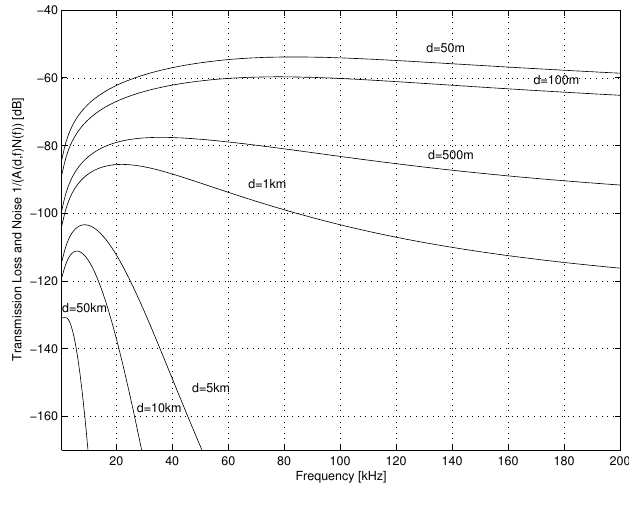
Figure 1. Narrow-band signal-to-noise ratio (SNR; 1 / ( AN ) ) as a function of frequency for varying transmission distance. Environmental factors used: practical spreading, k = 1 . 5 ; wind speed, w = 3 m/s; and moderate shipping activity, s = 0 . 5 .